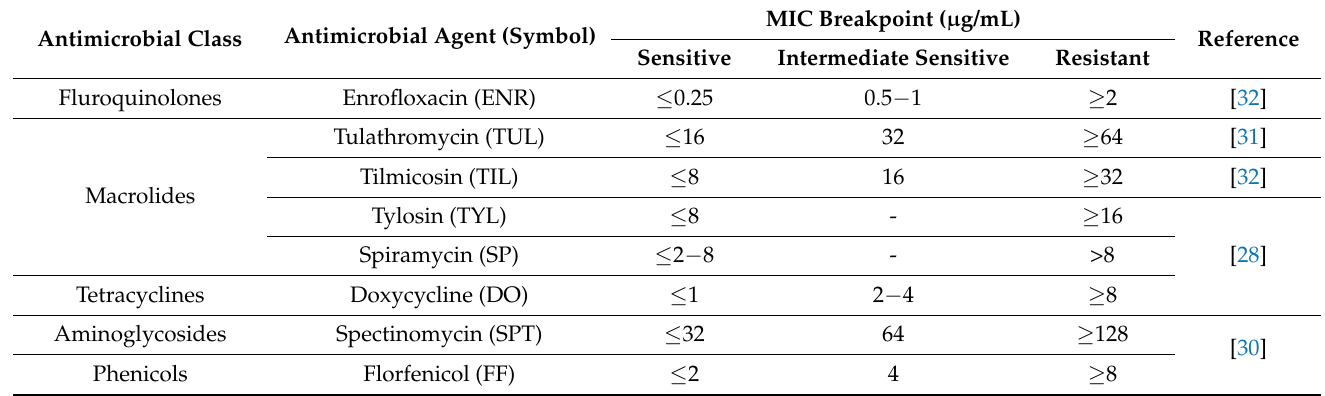
Table 2. Interpretative minimum inhibitory concentrations’ breakpoints of different antimicrobial agents against Mycoplasma